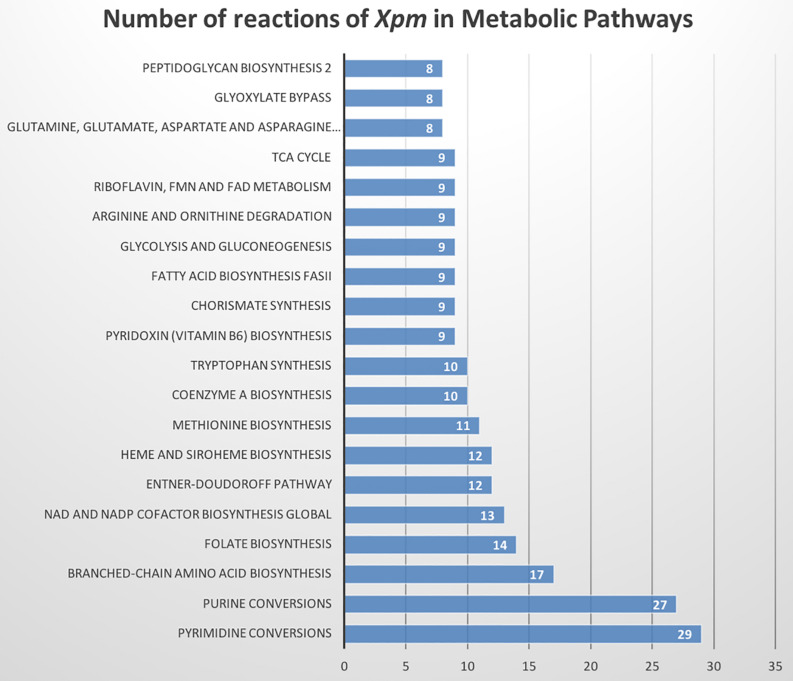
Metabolic pathways of Xpm CIO151. Bar graph of numbers of reactions in Xpm strain CIO151 assigned to each metabolic pathway. Only the top 20 most represented metabolic pathways are presented.